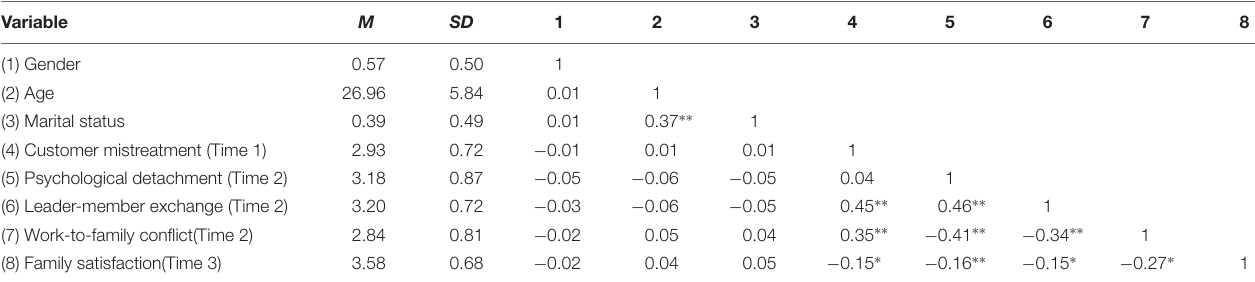
TABLE 1 | Mean, SD, and Person correlation for study variables. Variable